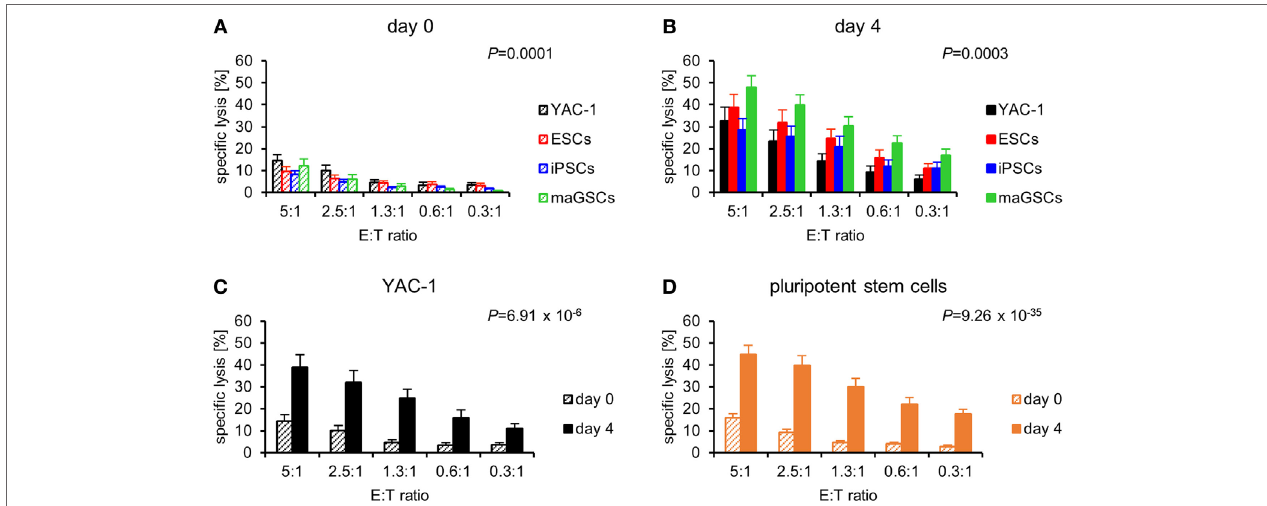
FigUre 3 | Pluripotent stem cells (PSCs) are more susceptible to interleukin (IL)-2-activated natural killer (NK) cells than resting NK cells. (a) A summary of means and SEM of specific lysis of YAC-1 cells ( n = 16), embryonic stem cells (ESCs) ( n = 14), induced pluripotent stem cell (iPSCs) ( n = 18), and multipotent adult germline stem cell (maGSCs) ( n = 16) by freshly purified NK cells (day 0) is shown as determined by 51 Cr-release assays. (B) A summary of means and SEM of specific lysis of YAC-1 cells ( n = 12), ESCs ( n = 12), iPSCs ( n = 12), and maGSCs ( n = 12) by IL-2-activated NK cells (day 4) is shown as determined by 51 Cr-release assays. The cytotoxic activity of resting (day 0) and IL-2-activated NK cells (day 4) has been compared for (c) YAC-1 cells and (D) all PSCs together. P -values for the comparisons (2-way-analyses of variance adjusted for E:T ratios) are